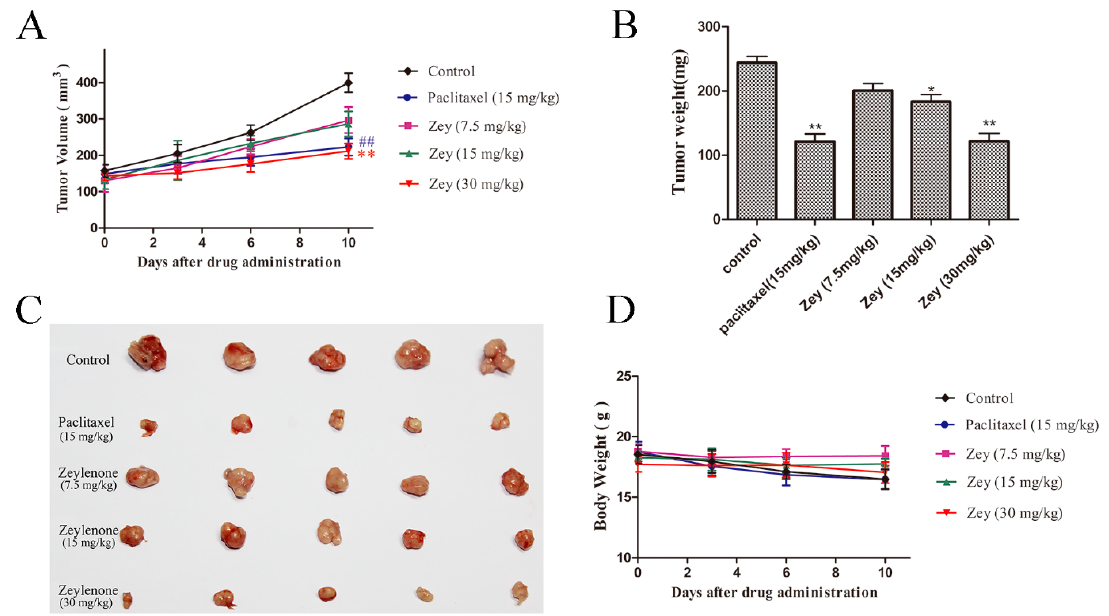
Figure 6. Zey inhibits tumor growth in nude BALB/c mice bearing BGC823 xenografts. BGC823 cells were transplanted subcutaneously to BALB/c nude mice and administered Zey (7.5, 15, and 30 mg/kg), paclitaxel (15 mg/kg), and saline (as the negative control) for 10 days. ( A ) Tumor volume was recorded every two days. Mean ± SD (n = 5). ## p < 0.01 and ** p < 0.01 vs. control group. ( B ) Tumor weight of each group. On day 10 after inoculation, the mice were sacrificed, and the tumor tissues were isolated, weighed, and summarized. Mean ± SD (n = 5). * p < 0.05 and ** p < 0.01 vs. control group. ( C ) Photographs of tumors in each group. ( D ) Body weight was measured every two days. Mean ± SD (n = 5).